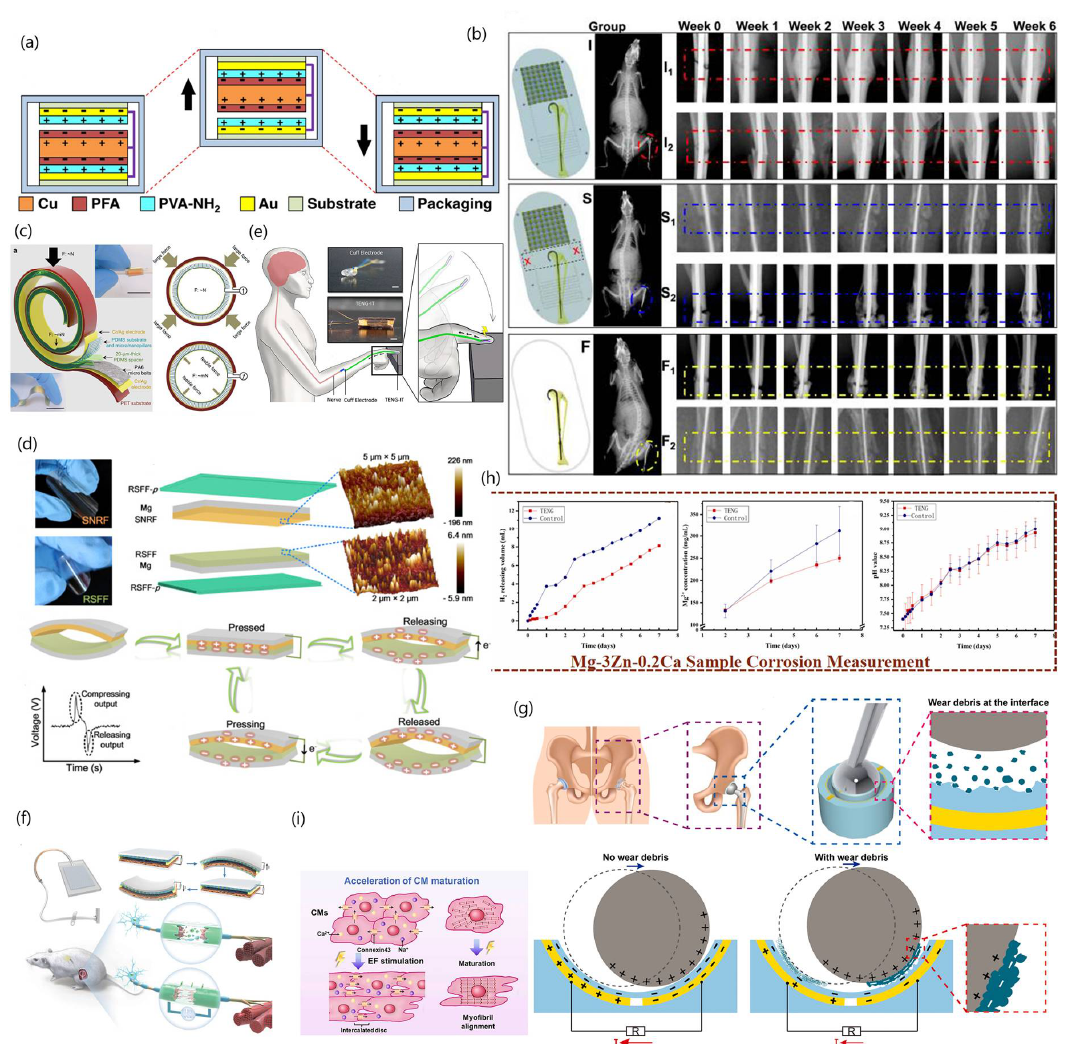
Figure 9. Application of implantable TENG. ( a ) The working mechanism of the I-TENG with the freestanding unit [49]; Copyright 2021, Nature Communications. ( b ) A series of X-ray radiographs on the bone fracture area over time of the intervention group (I), sham group (S), and false-implant group (F) (n = 7) [90]; Copyright 2021, Proceedings of the National Academy of Sciences. ( c ) The device structure of the ATNG; A 20- µ m-thick PDMS spacer is used to ensure an ultrashort working distance (20 µ m); The inset photos show an actual image of the ATNG [91]; Copyright 2020, Wiley-VCH. ( d ) Appearance of SNRF and RSFF; Schematic illustration of TENG structure; 3D AFM images of friction layers; Schematic diagram of the TENG working principle; Typical output voltage signal during one compression and release cycle [86]; Copyright 2020, Elsevier Ltd. ( e ) Illustration of the TENG-It. a. Use of TENG-IT for restoring tactile sensation [88]; Copyright 2021, American Chemical Society. ( f ) Design and working principle of the self-regulated neural electrical stimulation